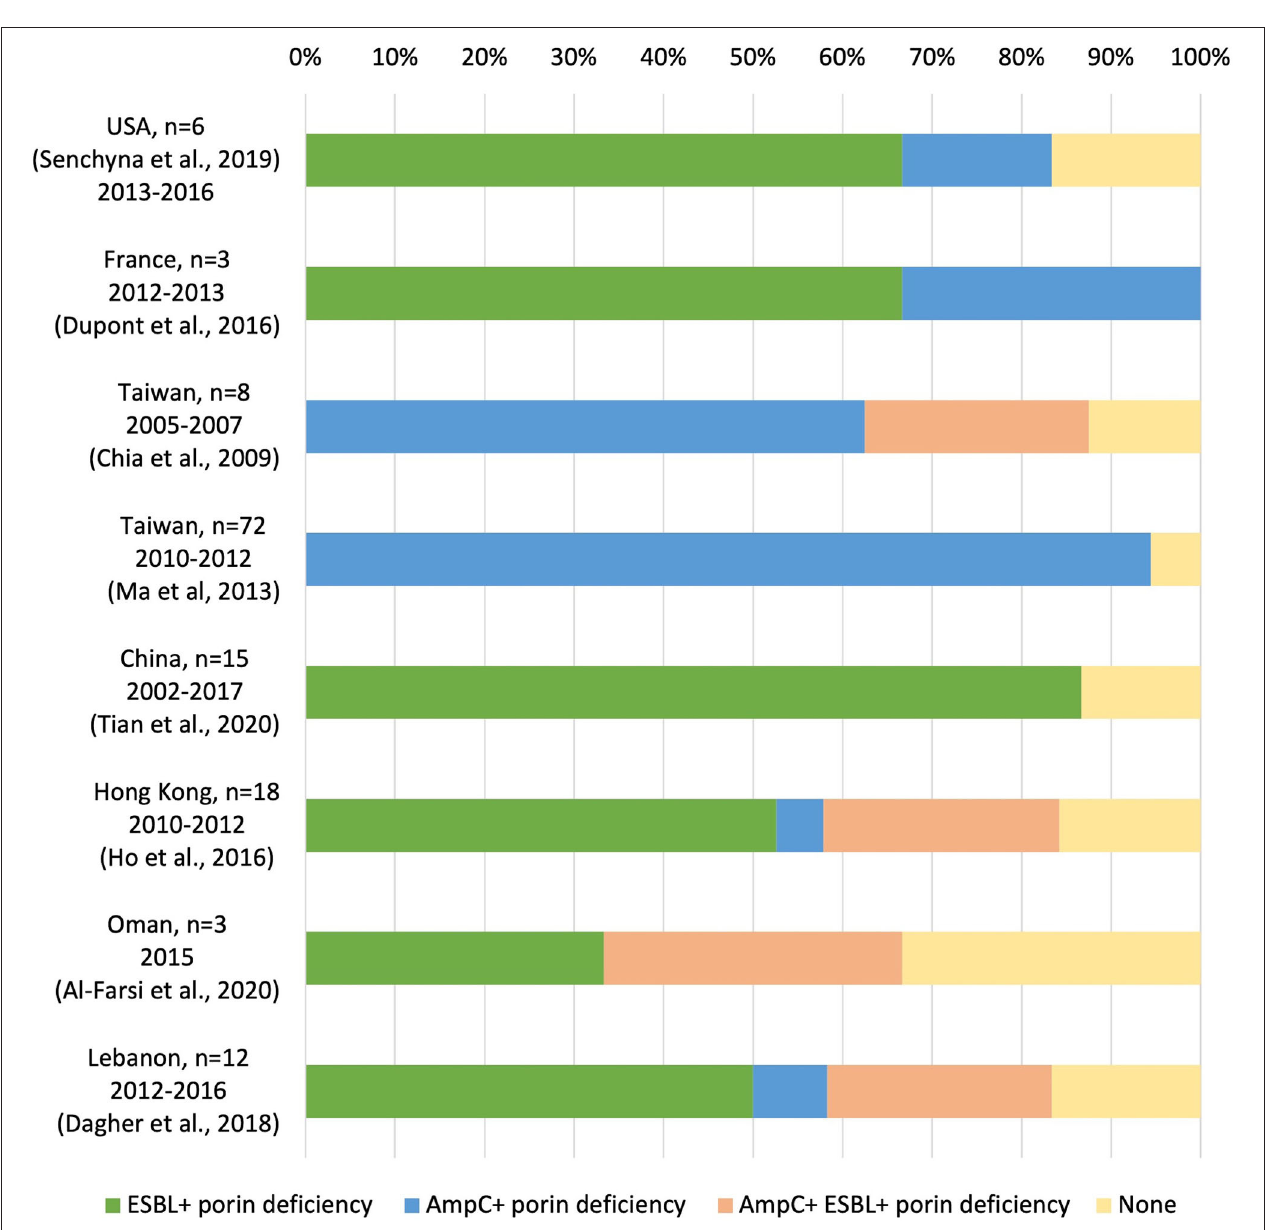
FIGURE 4 | Molecular resistance mechanisms in non-carbapenemase-producing carbapenem-resistant E. coli /carbapenem non-susceptible E.coli (non-CP-CREc /non-CP-CNEc) (Chia et al., 2009; Ma et al., 2013; Dupont et al., 2016; Ho et al., 2016; Dagher et al., 2018; Senchyna et al., 2019; Al-Farsi et al., 2020; Tian et al.,